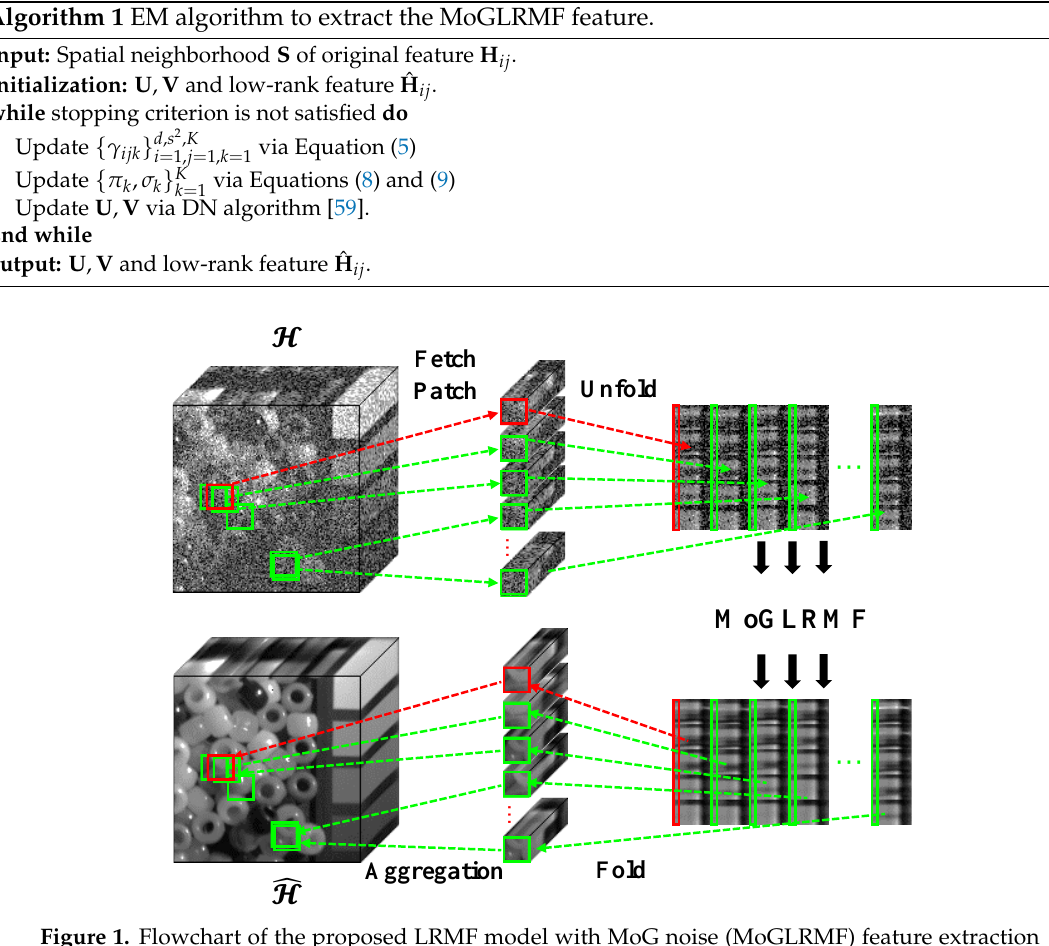
Figure 1. Flowchart of the proposed LRMF model with MoG noise (MoGLRMF) feature extraction algorithm. Firstly, we fetch each local patch and unfold it into matrix along the spectral dimension. Then, the MoGLRMF method is applied to each unfolded matrix, which is then folded back to local patch. Finally, each local patch is aggregated into the final feature